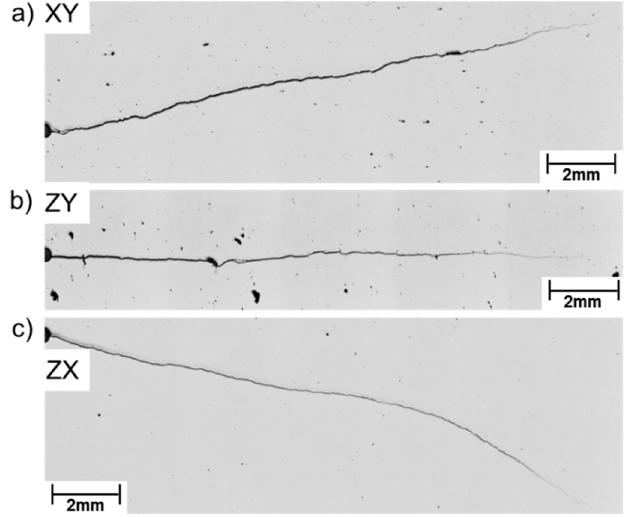
Figure 8. Exemplary distribution of pores with reference to build directions ( a ) XY, ( b ) ZY, and ( c ) ZX.